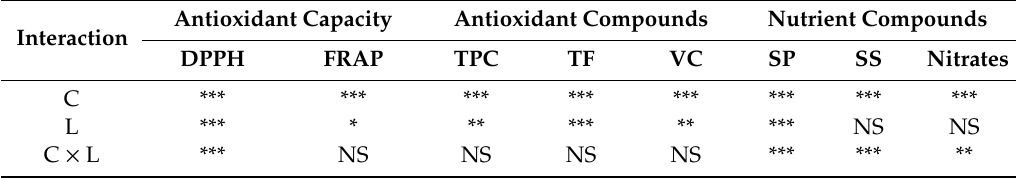
Table 5. The interaction e ff ects of cultivars and lightings on lettuce phytochemical contents. Antioxidant Capacity Antioxidant Compounds Nutrient Compounds Interaction